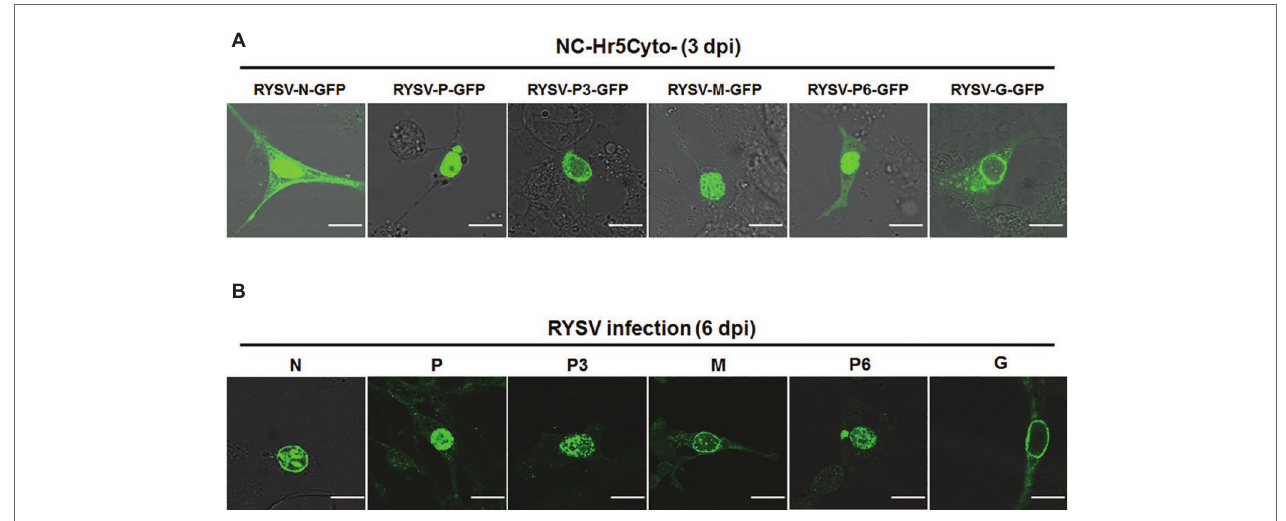
FIGURE 3 | Laser-scanning confocal micrographs showing the subcellular localization of RSYV-encoded proteins in N. cincticeps cells. (A) Fluorescence of N. cincticeps cells expressing GFP fusions of different RYSV-encoded proteins. Scale bar: 20 μm. (B) Confocal immunofluorescence micrographs showed the cellular localization of RYSV proteins in RYSV-infected N. cincticeps cells. Infected VCMs at 6 dpi after RYSV inoculation, immunolabeled with viral-specific IgGs directly conjugated to FITC. Scale bar: 20